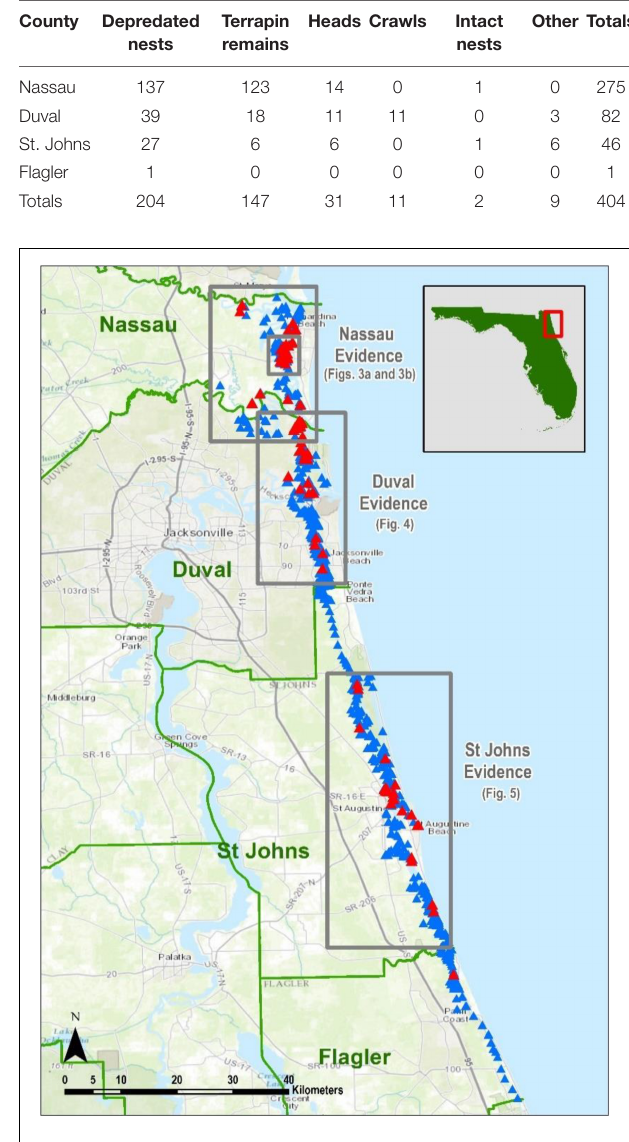
FIGURE 2 | Northeast Florida study area with the three evidence centers outlined and labeled as Nassau, Duval, and St. Johns evidence, with an important Terrapin concentration at Jackson Creek ( Figure 3B ). Blue triangles depict all places where we conducted surveys. Red triangles indicate locations where evidence of Terrapins was found, and each represents between 1 and 102